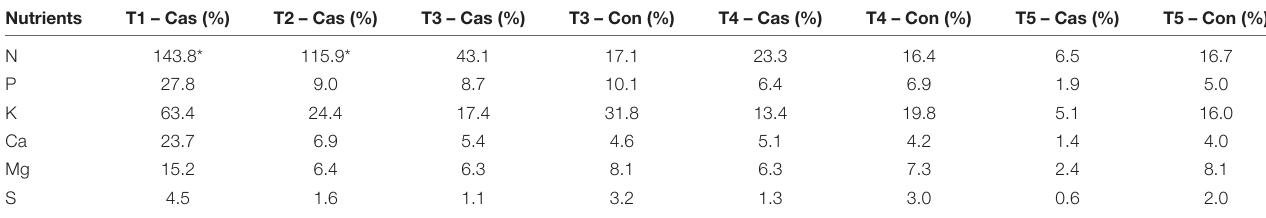
TABLE 2 | Uptake (%) of irrigated nutrient per plant in cascade treatments.